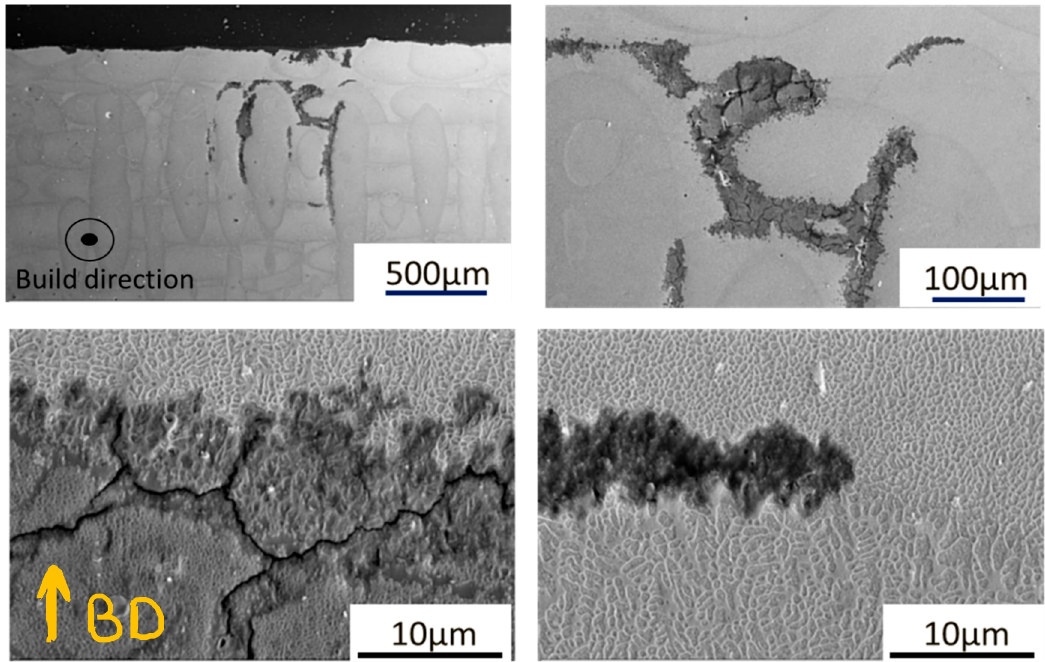
Figure 6. SEM micrographs of the cross-section of the as-built SLM sample after corrosion testing.